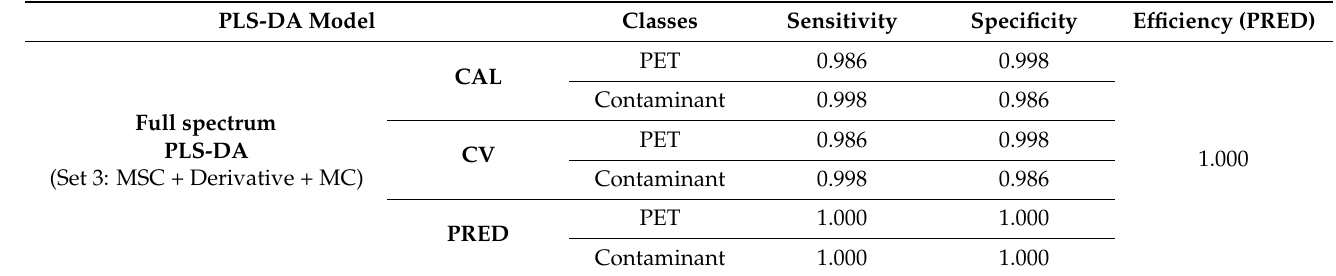
Table 6. Full spectrum PLS-DA (Set 3: MSC + Derivative + MC) classification performances for calibration (CAL), cross- validation (CV), and prediction (PRED)